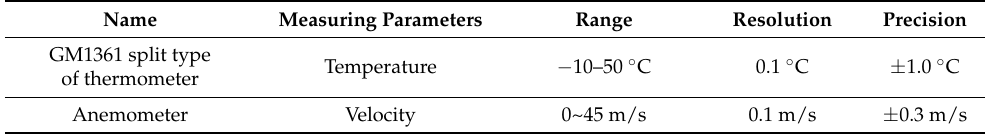
Table 2. Measurement device